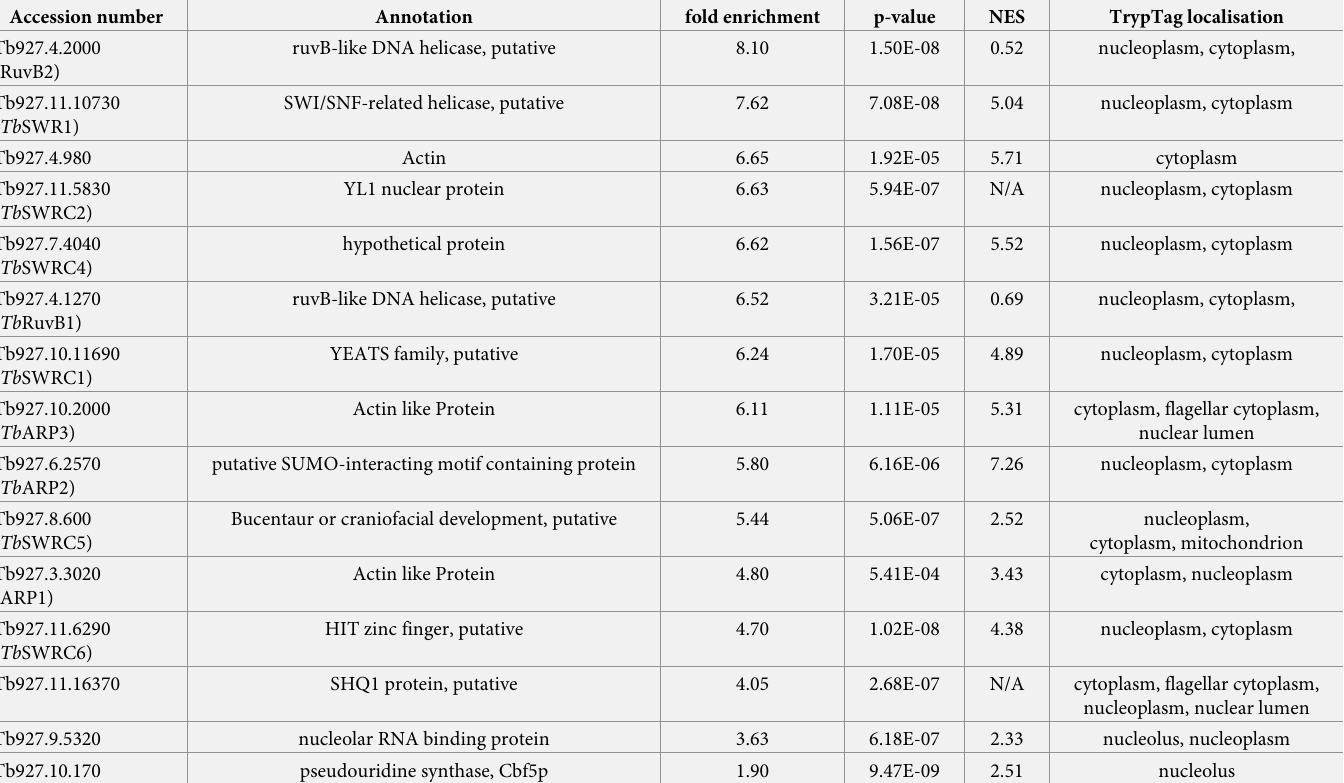
Table 1. Summary of the RuvB2 co-IP. 15 proteins with a positive or unknown nuclear enrichment score were identified by MS in the RuvB2-HA co-IP. The nuclear enrichment score (NES; (52)) indicates the probability of a nuclear localisation based on cell fractionation combined with quantitative MS analysis. The “Annotation” col- umn indicates the curated annotation that was found for the corresponding accession number on the TriTyp database. In the “p-value” column a probabilistic confidence measure ( P - value ) is assigned to each identified protein. The fold enrichment compared to the WT control is stated for every identified protein. The column "TrypTag localisation” indicates the cellular localisation of N- and C-terminally tagged